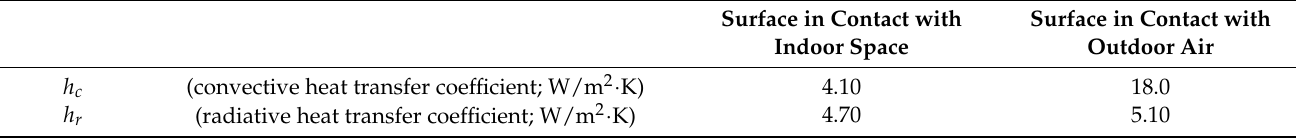
Table 3. Values of convective and radiative heat transfer coefficients.